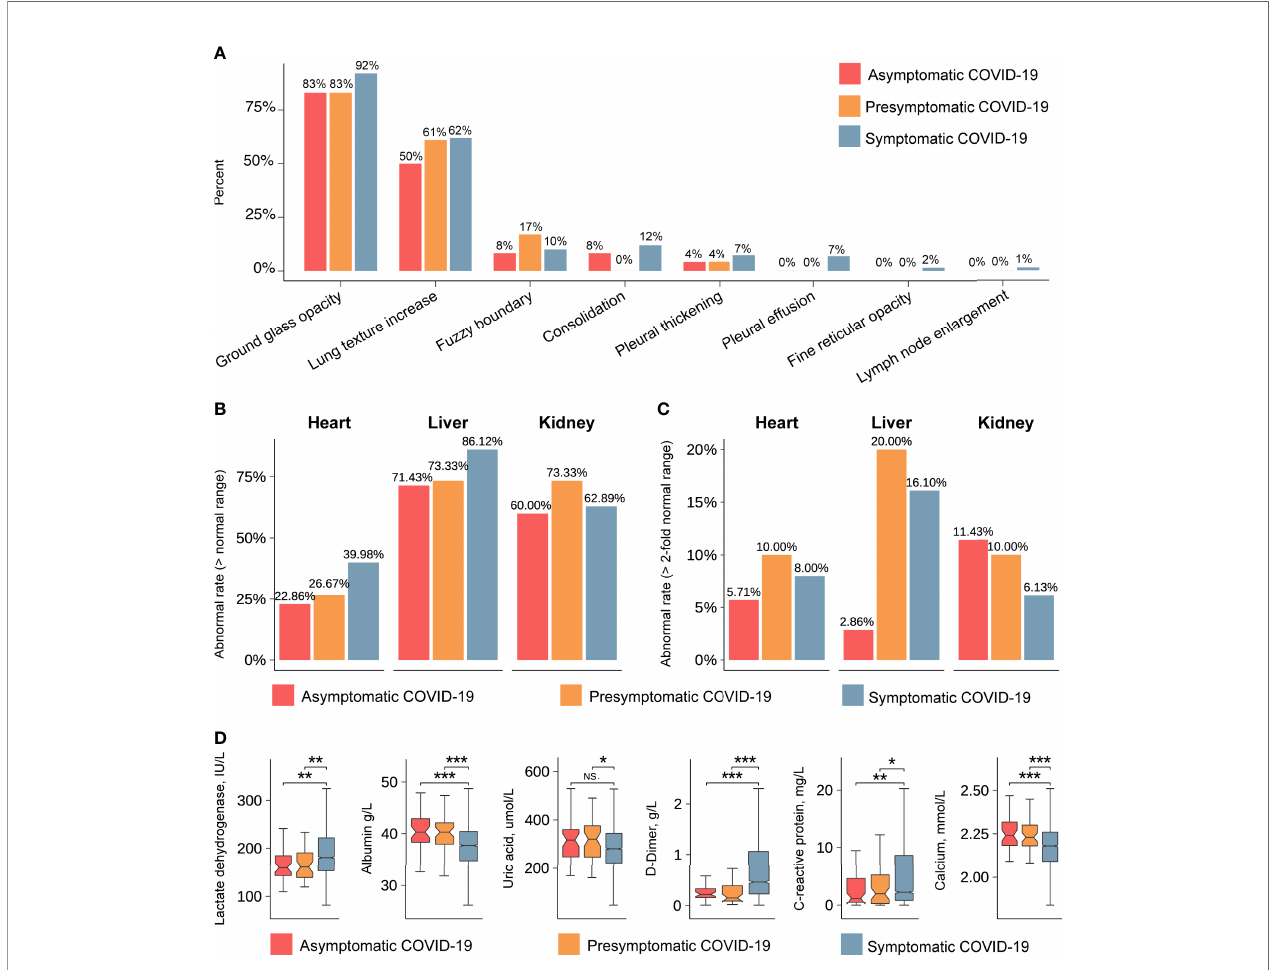
FIGURE 3 | Radiological characteristics and laboratory indicators detected in asymptomatic, presymptomatic, and symptomatic patients. (A) The percentages of typical characteristics in chest CT imaging. The vertical axis indicates the percentages of typical characteristics. The horizontal axis represents the typical characteristics of the lung. Red, orange and blue represent the asymptomatic, presymptomatic, and symptomatic group, respectively. (B) The abnormal rate of organs, including heart, liver, and kidney (> normal range). The vertical axis indicates the rate of abnormal. (C) The abnormal rate of organs, including heart, liver, and kidney (>2-fold normal range). (D) The values of laboratory indicators after admission. The vertical axis indicates the values of laboratory indicators. The P -value was calculated using the Wilcoxon ’ s rank-sum test and shown at the top of each panel. Boxplots represent the 25th and 75th percentiles, with midlines indicating the median values. *** represents P -value < 0.001. ** represents P -value < 0.01. * represents P -value < 0.05. NS. represents P -value >